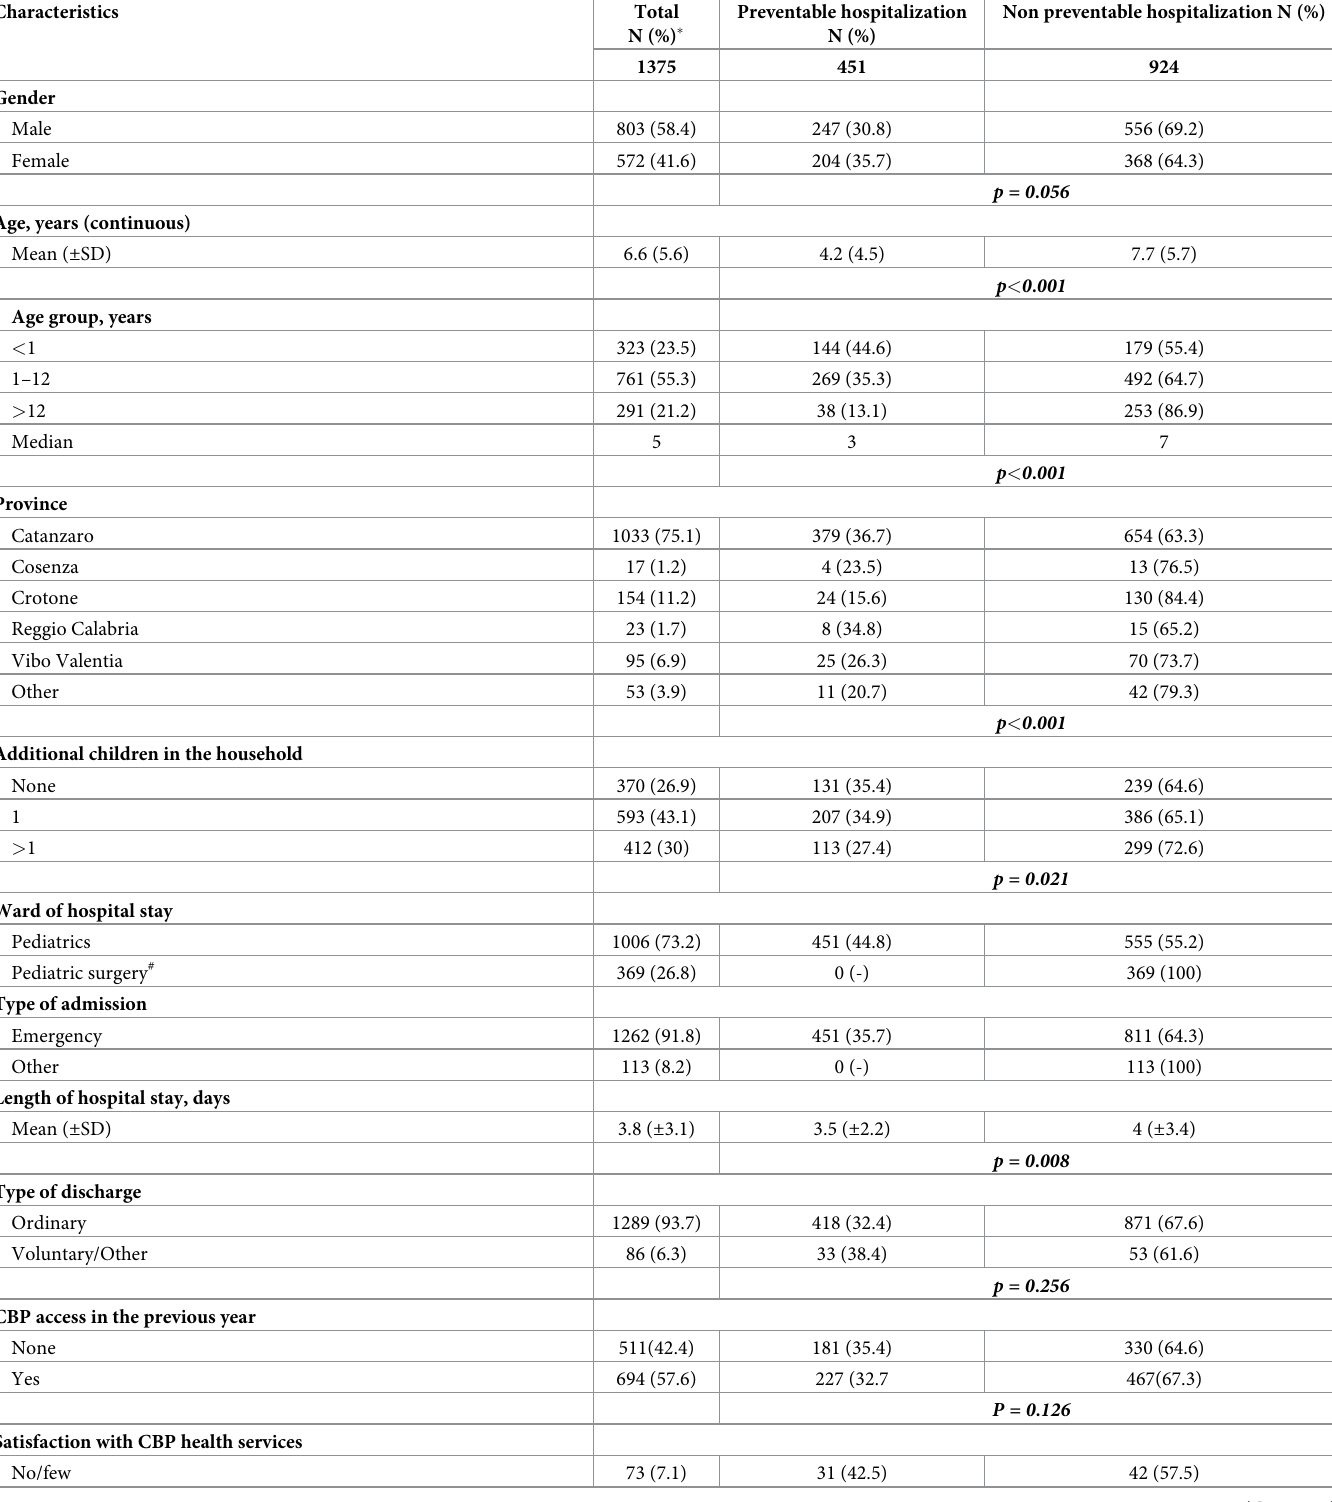
Table 2. Selected characteristics of the study population according to type of hospitalization (preventable/non preventable).